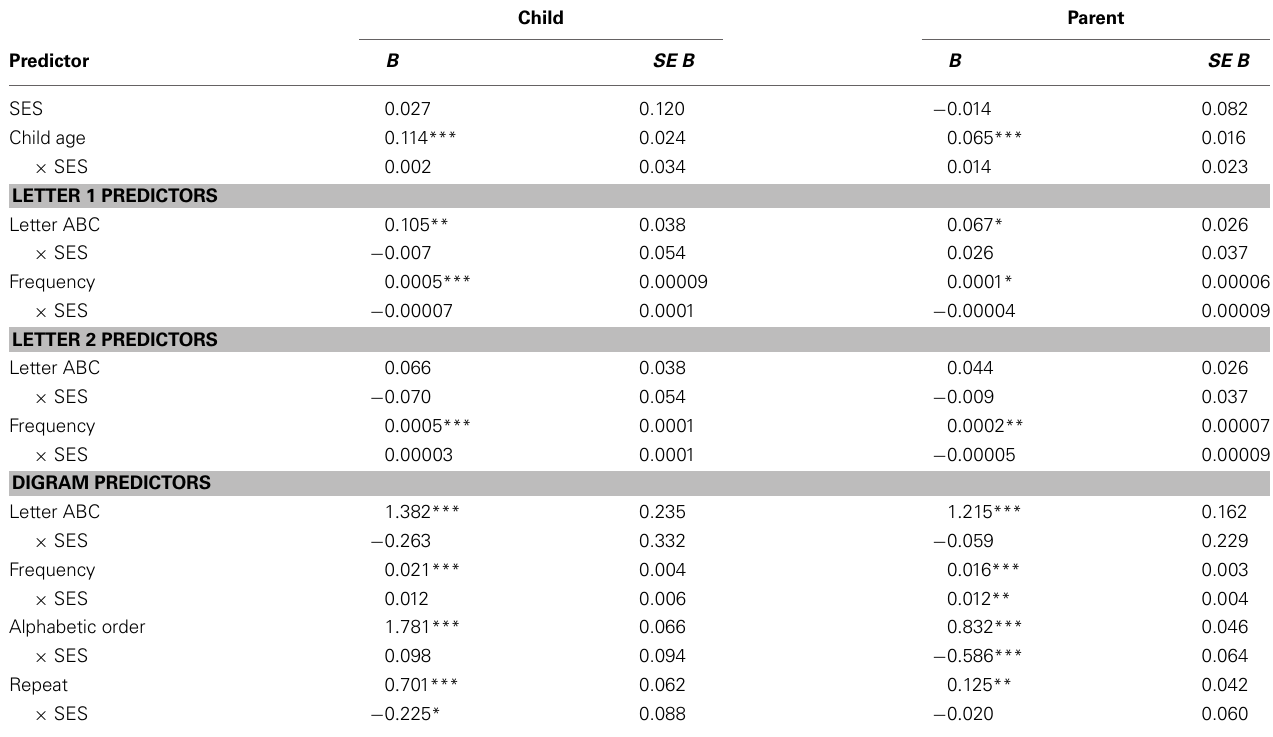
Table 5 | Summary of regression analyses for predictors of child and parent digram utterances in analysis